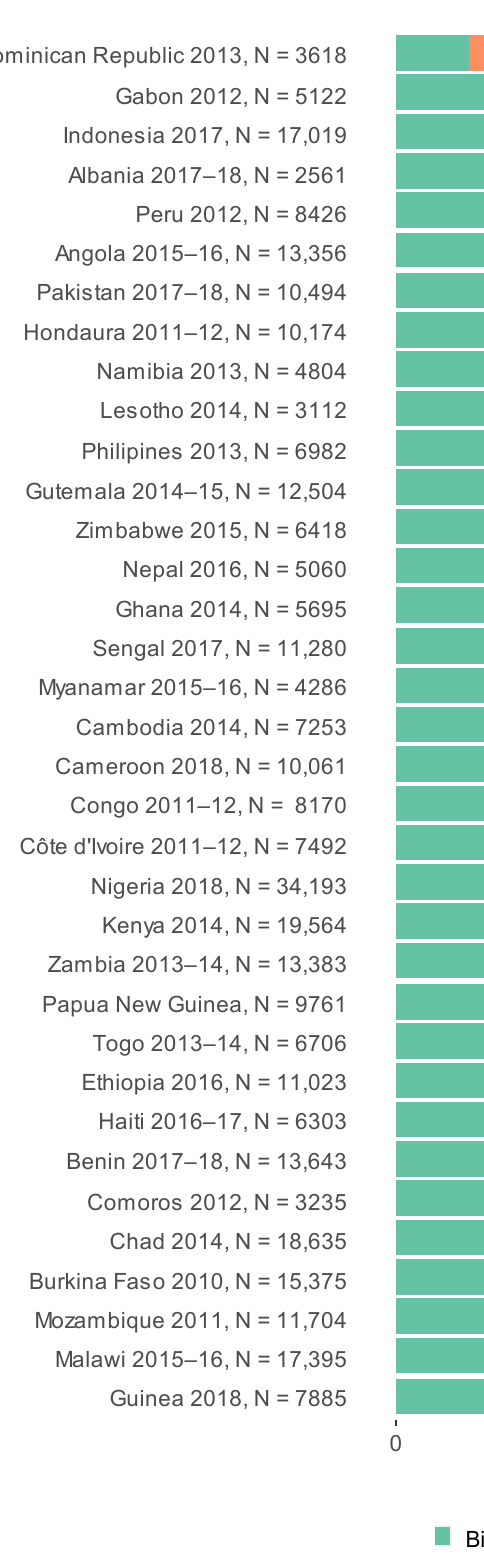
Figure 3. Proportion of children residing in households using cleaner and biomass cooking energy sources by country.